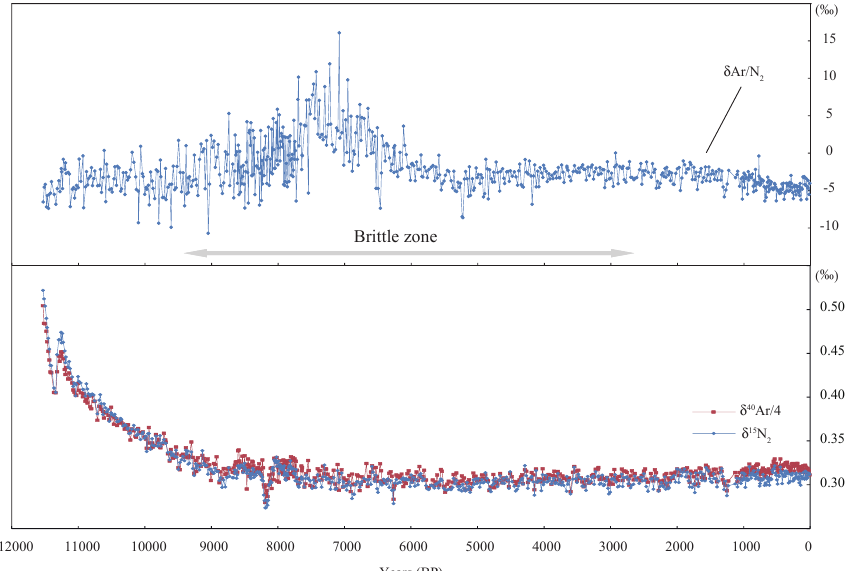
Figure 4. δ 15 N, δ 40 Ar/4, and δ Ar / N 2 from the GISP2 ice core over the Holocene (Kobashi et al., 2008b). The grey arrow indicates the brittle zone (Gow et al.,